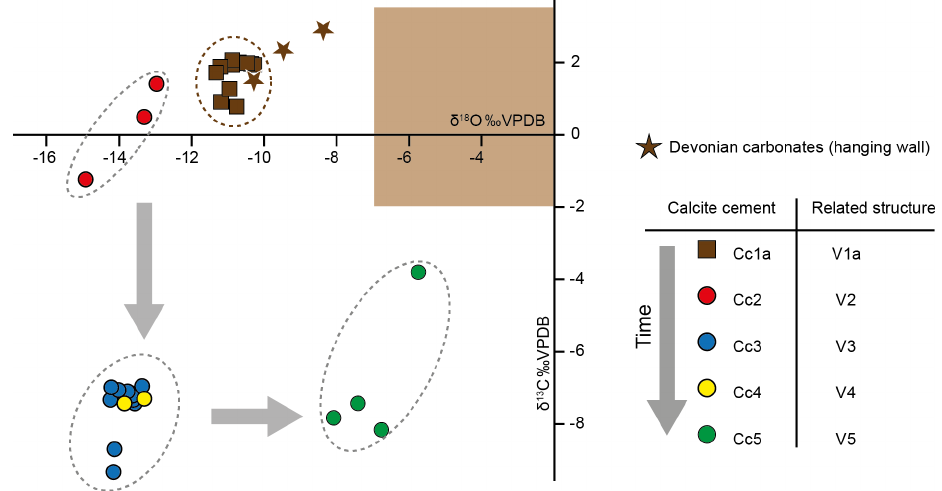
Figure 9. δ 18 O and δ 13 C values of calcite cements Cc1a to Cc5 and the Devonian carbonates from the hanging wall. Arrows indicate evolution over time according to the inferred relative timing of cements. The brown box refers to typical values of Devonian marine carbonates (Veizer et al., 1999).